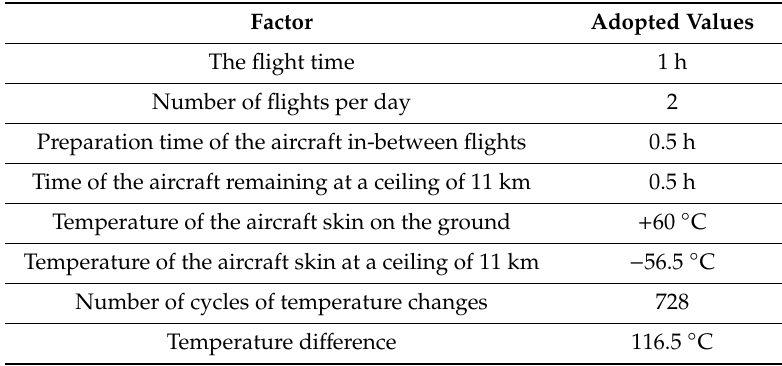
Table 3. Research assumptions of thermal shocks.